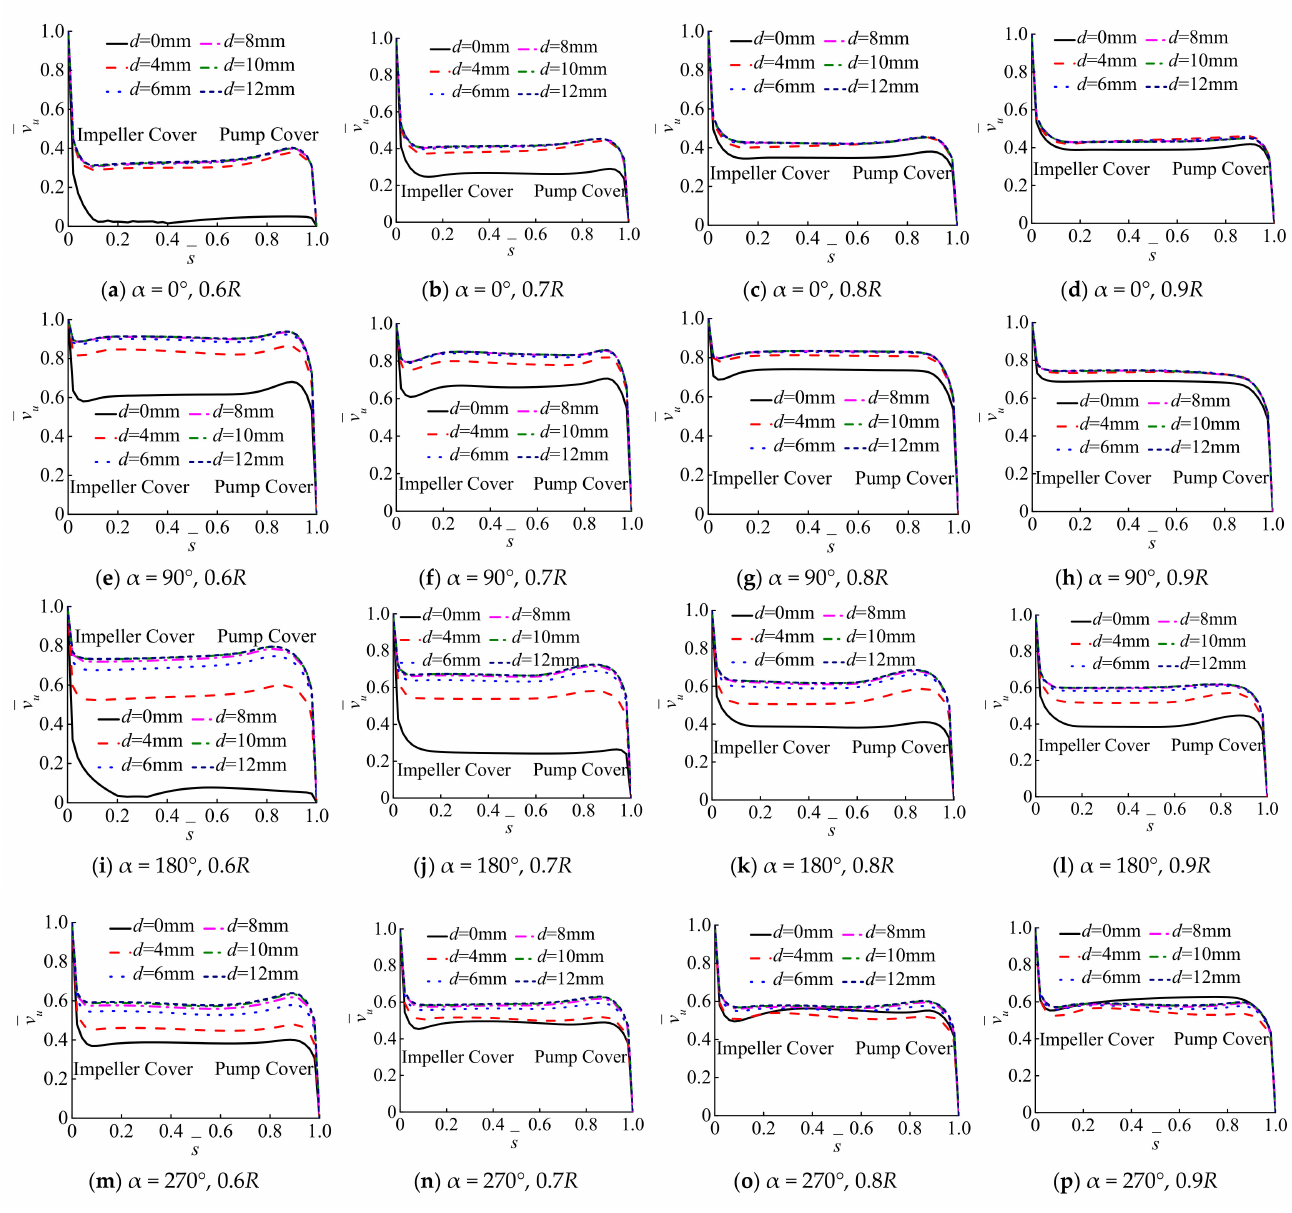
Figure 7. Axial distribution of non-dimensional tangential velocity. The non-dimensional tangential velocity of the liquid in the radial direction which causes the tangential direction of the same radius and the same angle approaches and is uniform, and the value is large. It is indicated that as the diameter of the balance hole increases, the pressure energy and kinetic energy of the rear chamber increase. Under the same balance hole diameter, the non-dimensional tangential velocity of the liquid in the core region of 0 ◦ with the same radius is the smallest, and the non-dimensional tangential velocity of the liquid in the core region of 90 ◦ with the same radius is the largest. When the balance hole is opened ( d from 4 mm to 12 mm), in the axial directions of 0, 90, 180, and 270 ◦ of the same radius, the non-dimensional tangential velocity of the liquid in the flow core region is largely different. The non-dimensional tangential speed is the largest especially at 90 ◦ . At the 270 ◦ angle, the non-dimensional tangential velocity is the smallest, indicating that the pressure difference at the fifth section of the volute, the pressure potential energy and kinetic energy are small. Especially at 90 ◦ and 270 ◦ , when the d = 6 mm, compared with that of d = 4 mm, the circumferential velocity at the same radius increases